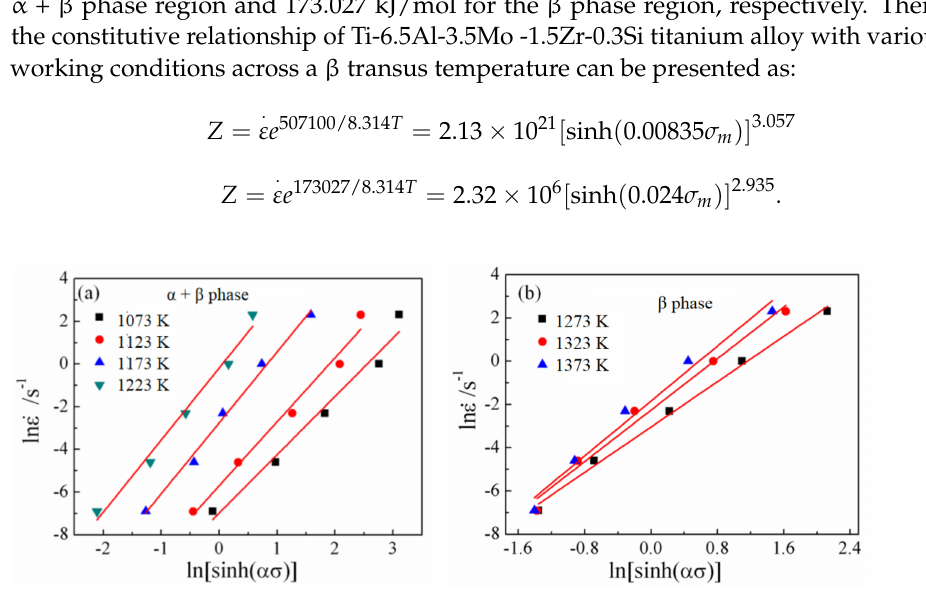
Figure 10. Relationships between ln region and ( b ) β phase region.